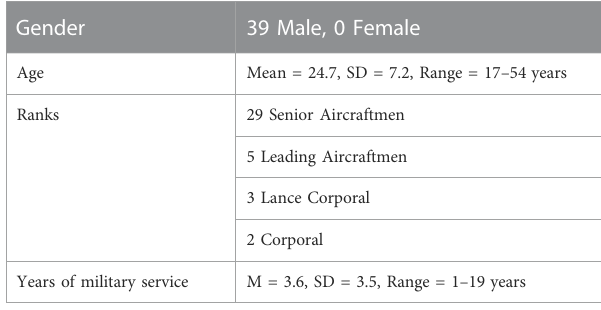
TABLE 1 Participant demographics.